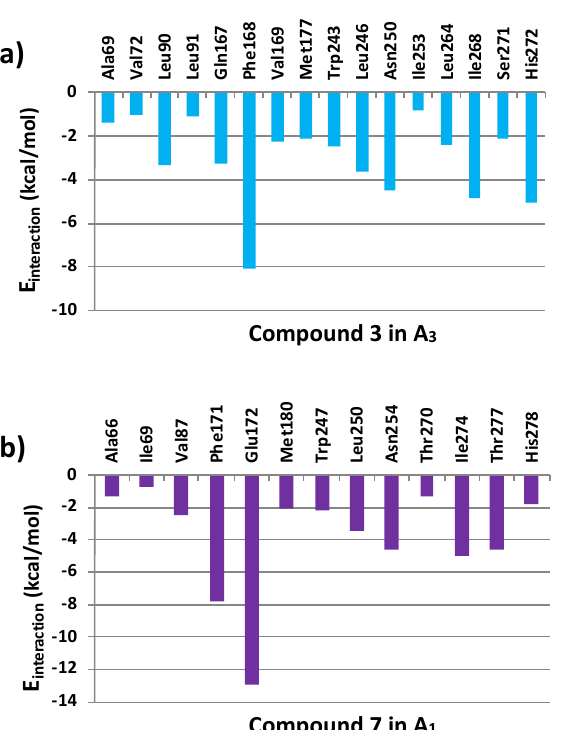
Figure 3. Interaction energy contribution (sum of Coulomb, van der Waals and hydrogen bond energies) between the residues in the ( a ) h A 3 and ( b ) h A 1 and the respective derivatives 3 and 7 (residues in a distance of 3 Å from the ligand).